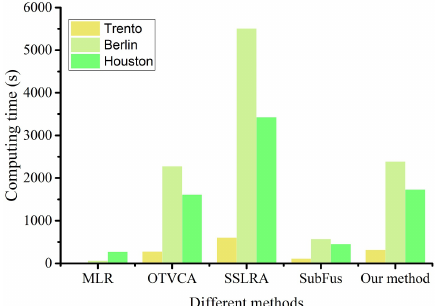
Figure 9. Running time of different approaches on three